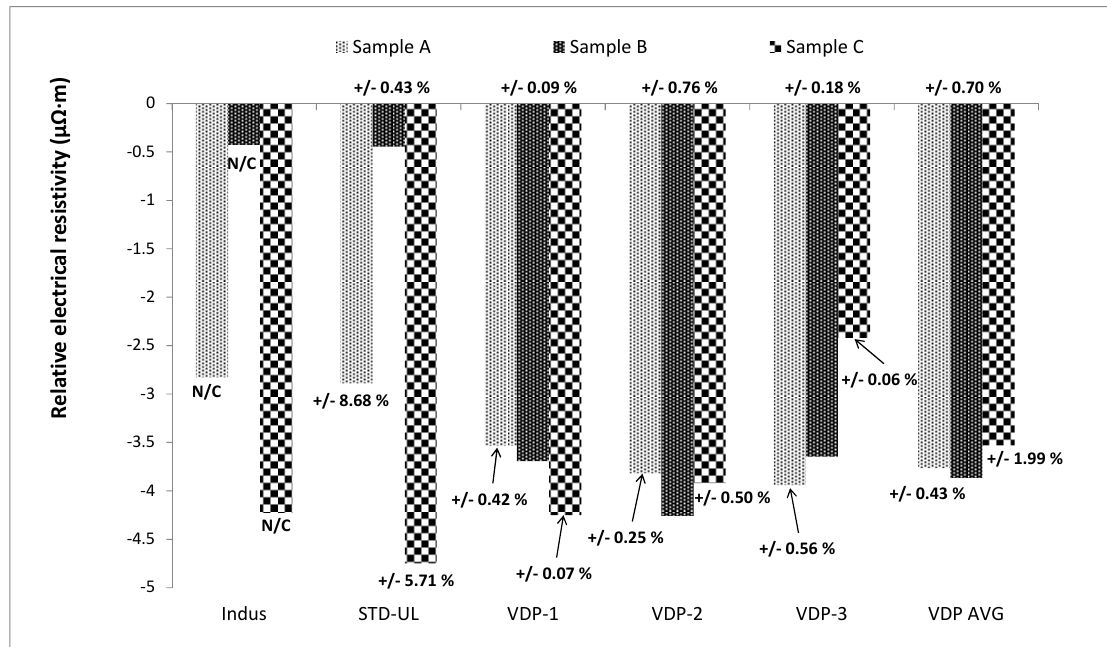
Figure 7. Comparison of standard and Van der Pauw (VdP) methods for intact samples cored from the industrial laboratory. “Indus” and “STD-UL” are the measurements provided respectively by the industrial laboratory and those achieved using standard method in our laboratory. “VDP (1-3)” are measurements performed on slices 1, 2 and 3 of each sample (VdP method); VDP-AVG is the average of the three combined measurements.